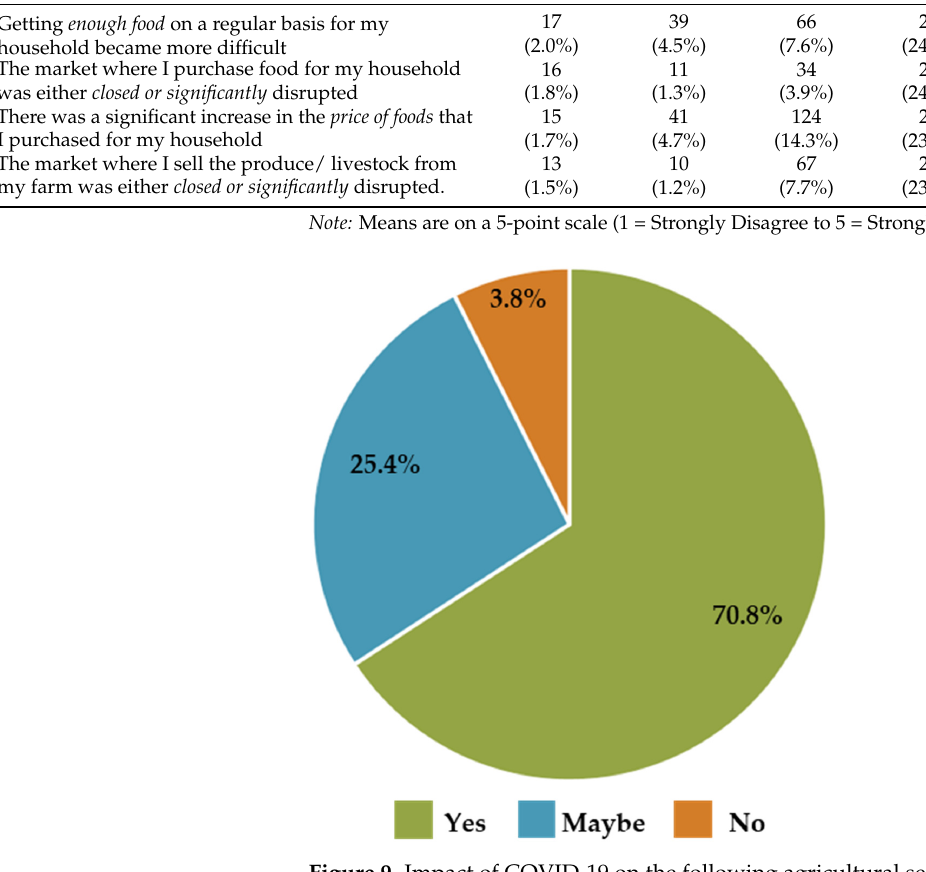
Figure 9. Impact of COVID-19 on the following agricultural season. Table 14. Thinking about your experiences of what occurred due to COVID-19, please indicate your level of agreement for each of the following statements.